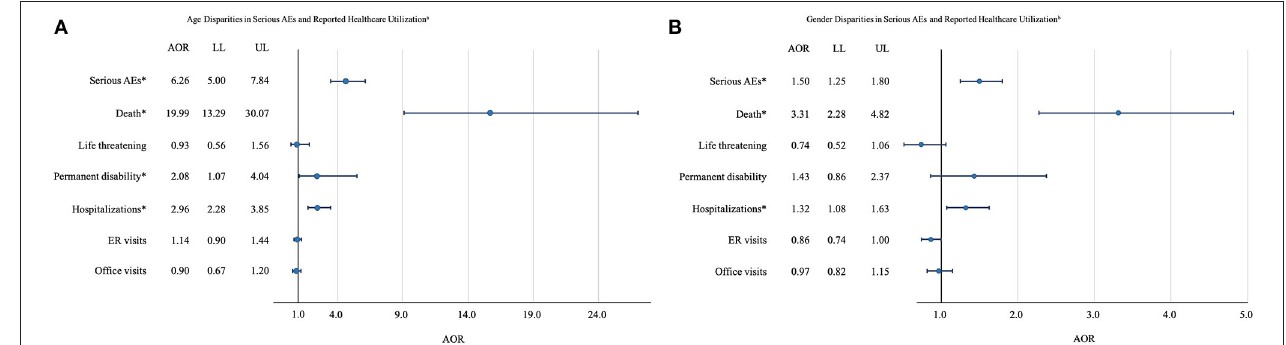
FIGURE 3 | (A) Age disparities and (B) gender disparities in serious AEs, ER visits, and office visits among adults who had AEs following COVID-19 vaccination in VAERS. The circle represents the point estimate of AOR. The length of the line represents the 95% CI of the AOR. Hospitalizations include hospitalization and existing hospitalization prolonged. AEs, Adverse events; AOR, Adjusted odds ratio; LL, Lower limit; UL, Upper limit; CI, Confidence interval; ER, Emergency room; COVID-19, Coronavirus disease 2019; VAERS, Vaccine Adverse Event Reporting System; a Adults aged 65 years or older vs. adults aged between 18 and 65 years. b Males vs. females. *Significant at 0.05 confidence